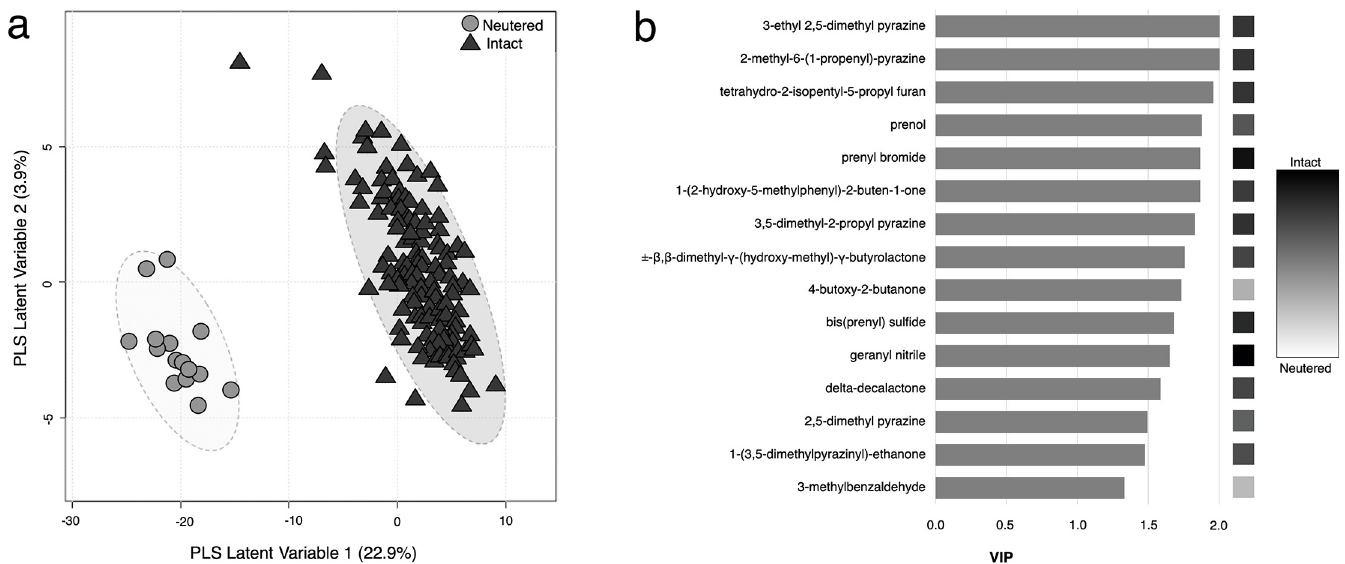
Fig 2. VOCs with highest variable importance in classifying intact male and neutered male urine samples. (a) Scores on first 2 latent variables from partial least squares-discriminant analysis shown for neutered male samples (n = 15) in gray circles and intact male samples (n = 141) in black triangles. Variance explained by each latent variable is shown in parentheses. (b) Variable influence on projection (VIP) scores on partial least squares latent variable 1 shown for 15 VOCs with statistically significant differential expression and highest VIP. Boxes on right indicate the log 2 fold change in abundance of each VOC in intact male samples (n = 141) compared to a neutered male’s samples (n =